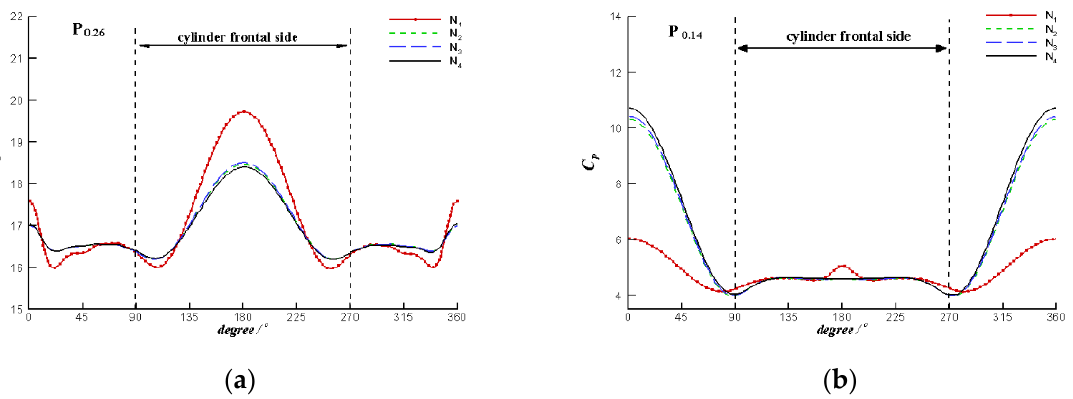
Figure 10. Comparison of the pressure distribution between N1 and N 2 –N 4 . ( a ) y = 0.26 m, ( b ) y = 0.14 m.